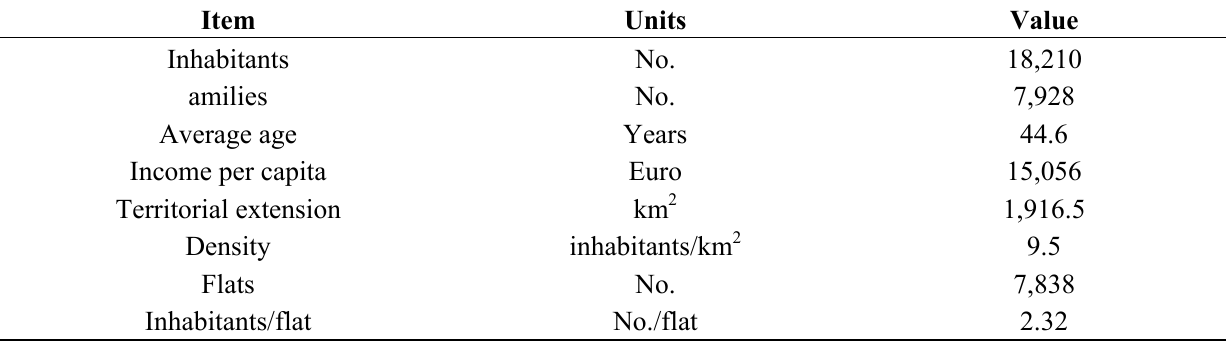
Table 1. Territorial and population data for the city of Melzo in Italy (Source ISTAT census 2011